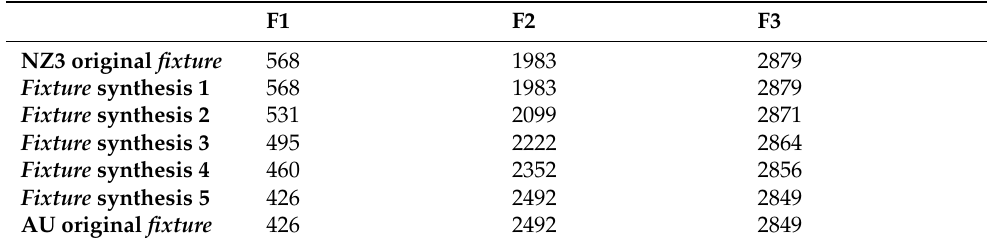
Table 3. Continua formant values (Hz) for the word ‘fixture’ at T-step 15 (median). F1 F2